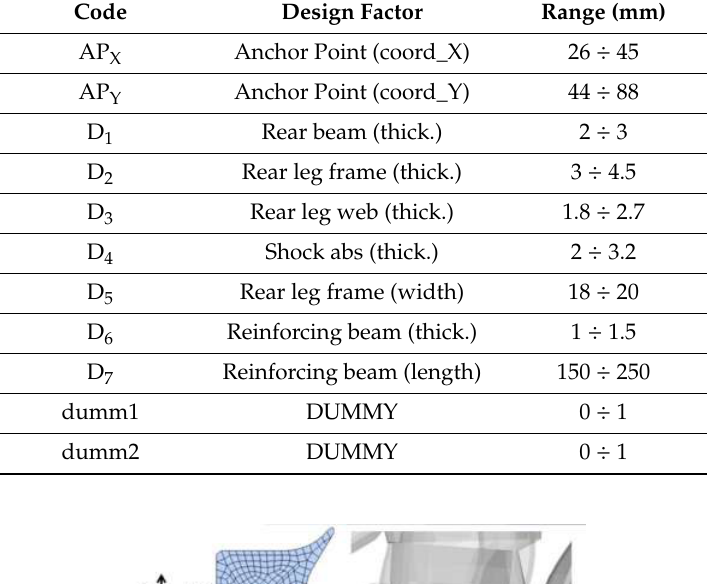
Table 1. Design factors and ranges.